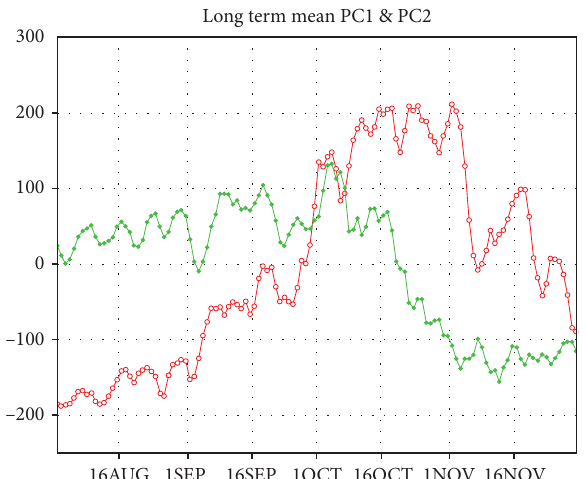
Figure 7: Climatological daily mean of the standardized PC1 ( red line ) and PC2 ( green line ) in the period of 1981–2010.